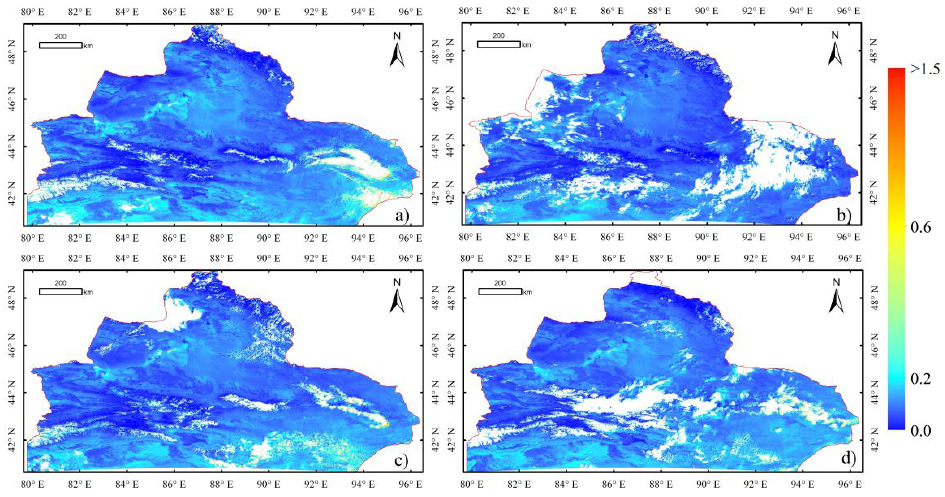
Figure 6. Retrieved AOD for the northern Xinjiang area. ( a ): 11 July 2014; ( b ): 15 July 2014; ( c ): 12 August 2014; ( d ): 21 August 2014.